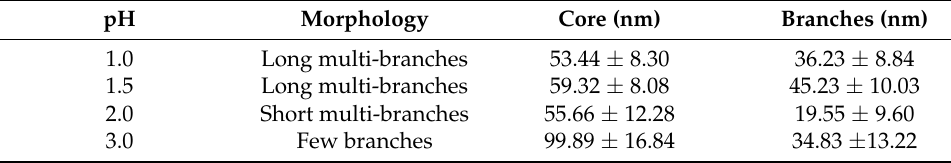
Table 4. The influence of pH to morphology, average core and branches of GNS.